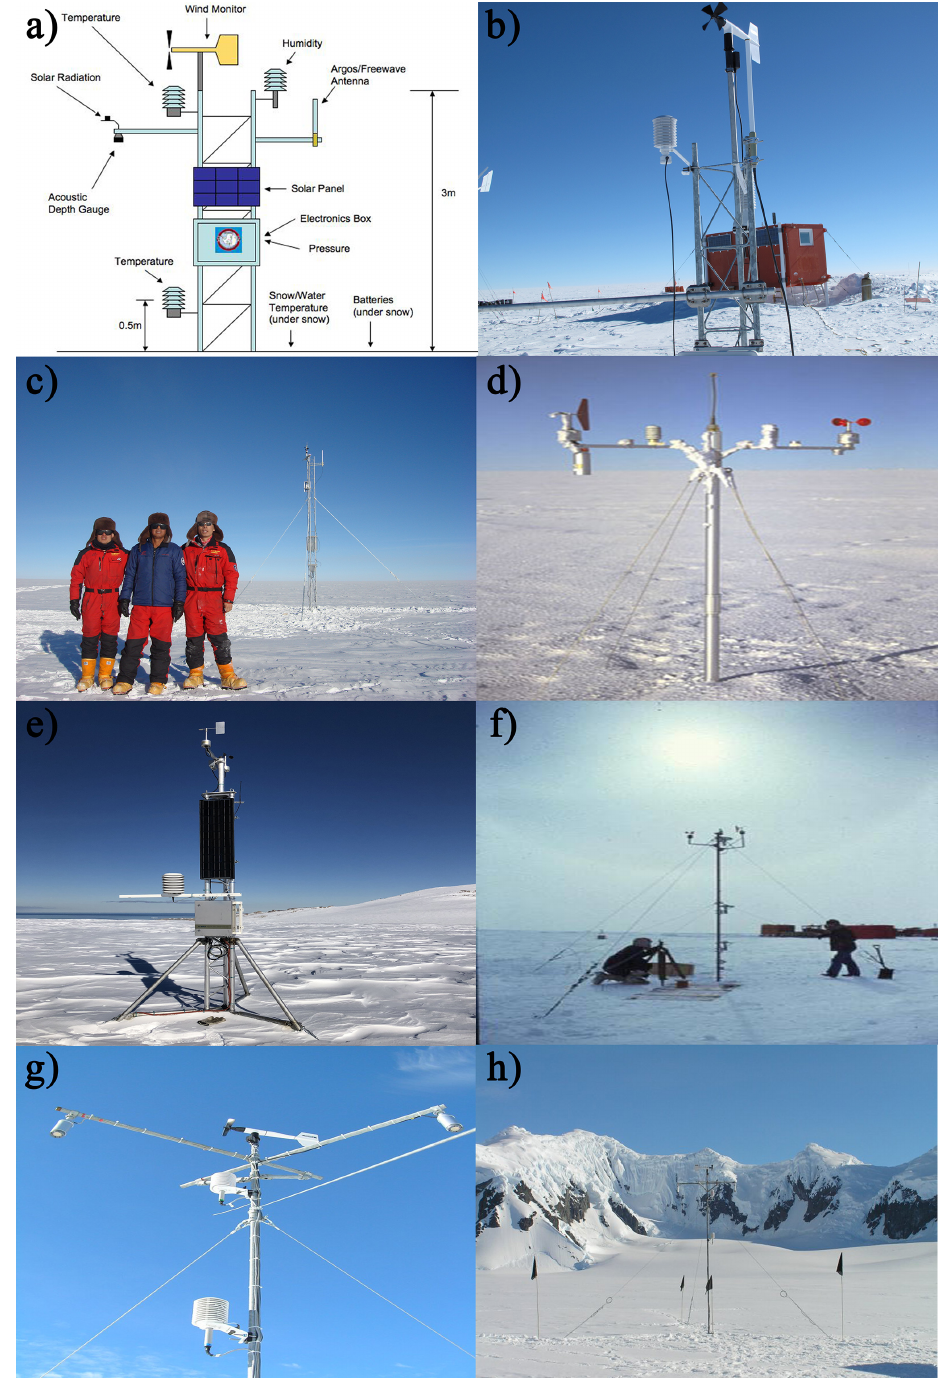
Figure 1. Typical AWSs of the six research institutions, but the sensors at other sites vary slightly depending on the local environ- ment. (a) AMRC-CR1000 device, (b) AMRC-AGO-4, (c) AMRC and CHINARE-Panda_South, (d) IMAU-AWS10, (e) PNRA-Maria, (f) AAD-LGB00, (g) BAS-the sensors used on Latady, and (h) BAS-Latady. (a) http://amrc.ssec.wisc.edu/news/2010-May-01.html (last access: 25 April 2022), (b) https://amrc.ssec.wisc.edu/aws/images/station_images/AGO_4.jpg (last access: 4 November 2022), (c)